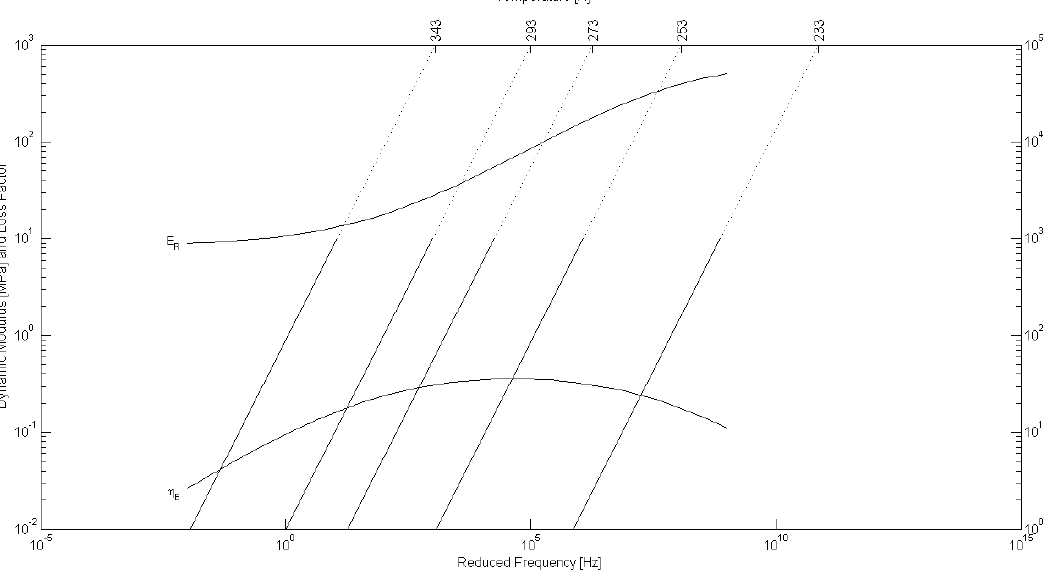
Figure A3. Reduced-frequency nomogram for Butyl Rubber BT 806-55; λ = 0.90 [29].